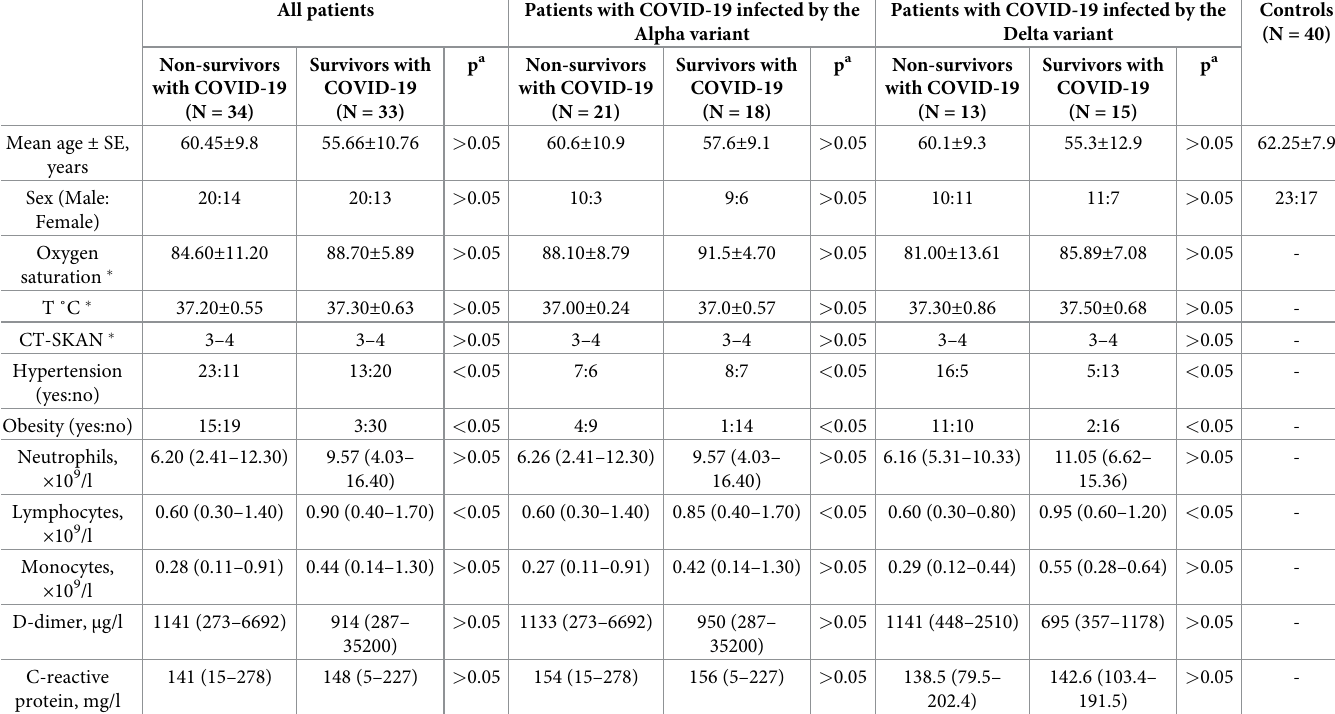
Table 1. Characteristics of the studied groups.